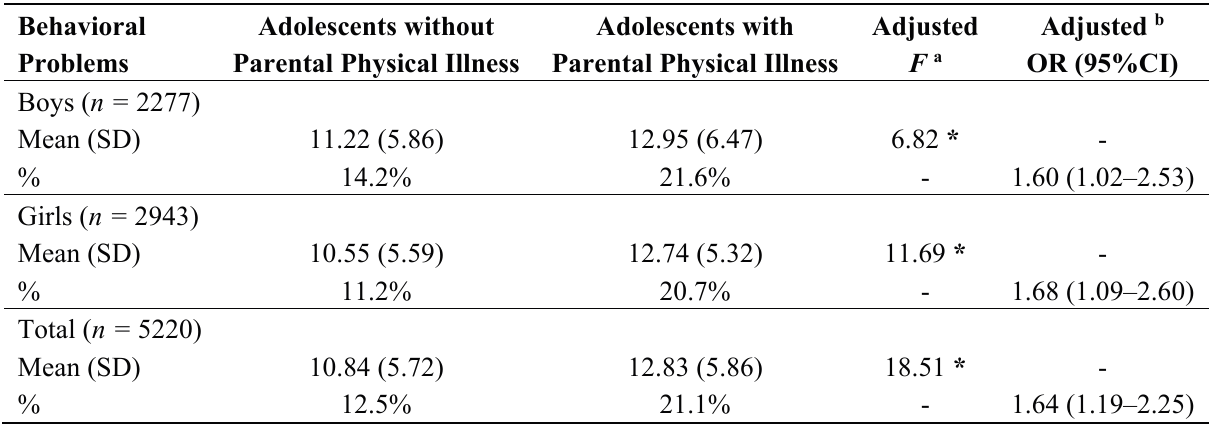
Table 2. The effect of parental physical illness on behavioral problems in the total